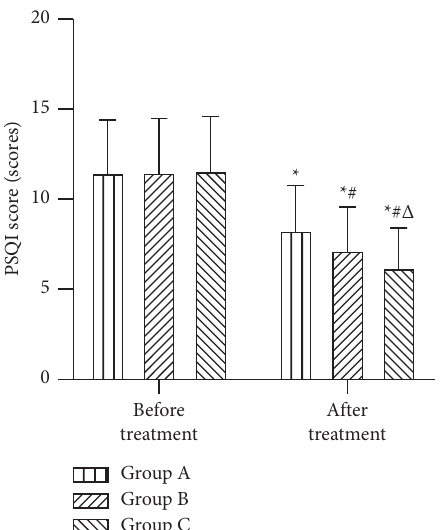
Figure 5: Comparison of 3 groups of PSQI scores ( x ± s , scores). Compared with the same group before treatment, ∗ P < 0 . 05; compared with group A after treatment, # P < 0 . 05; compared with group B after treatment, Δ P < 0 . 05.